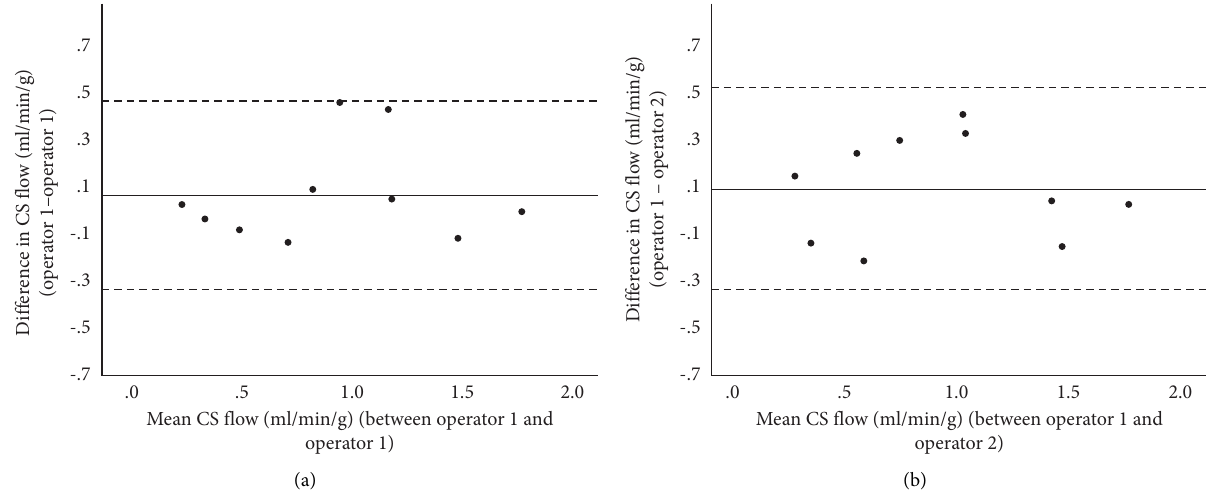
Figure 3: Bland–Altman plots demonstrating intra- (a) and inter- (b) observer repeatability. Te dark line represents the mean delta (bias) and the dotted horizontal lines represent the limits of agreement ± 1.96 SD above and below the